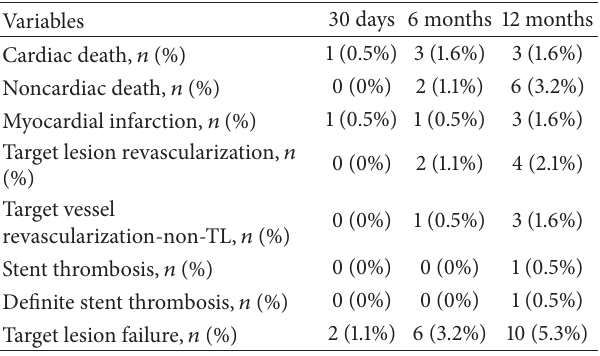
Table 4: Cumulative clinical outcomes up to 12 months ( 𝑛 = 189